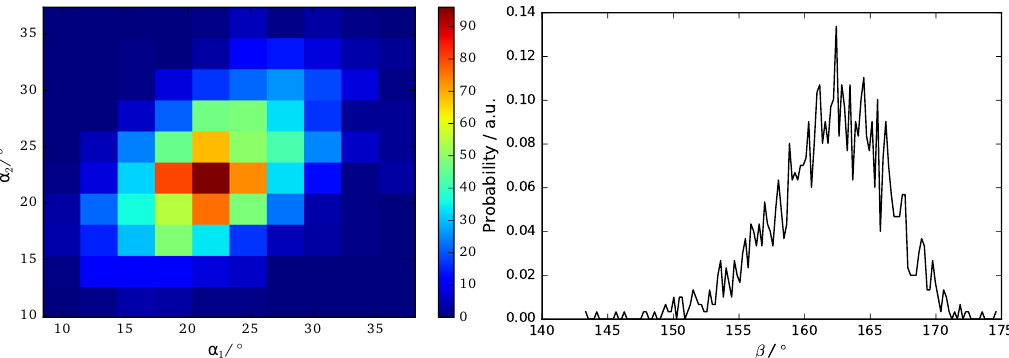
Figure 8. Probability distribution of backbone angles α 1 , α 2 and β